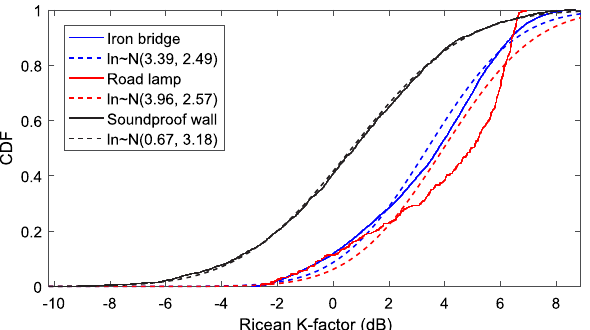
Figure 4. Cumulative distribution function of the Ricean